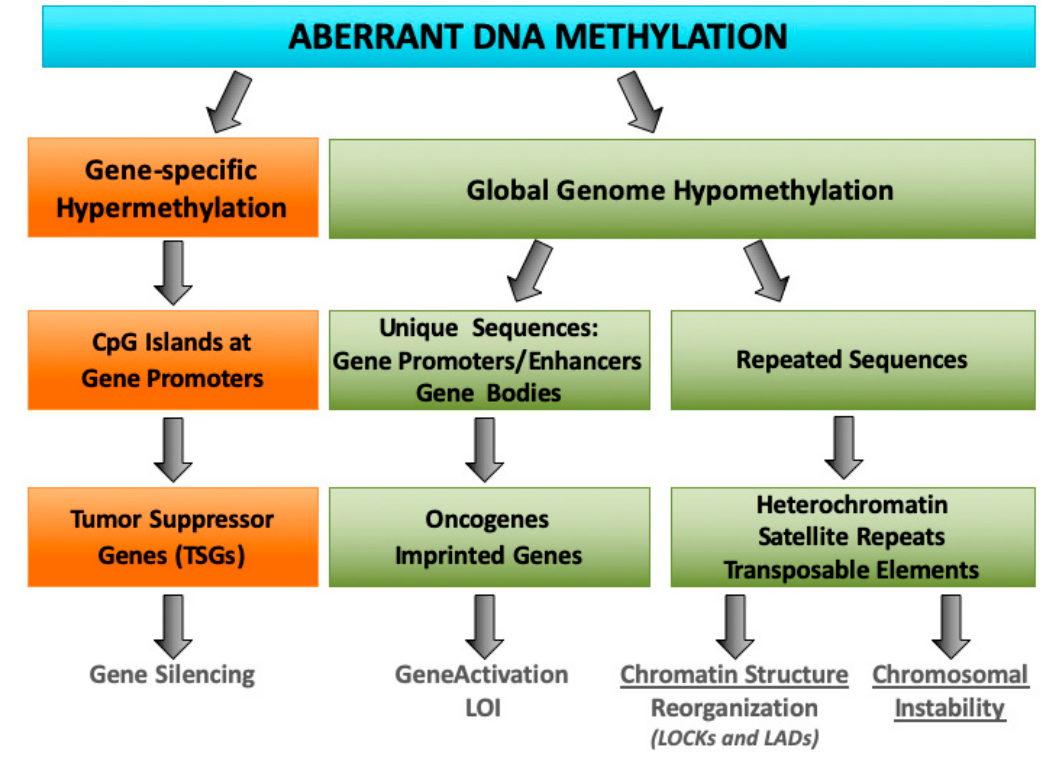
Figure 1. Scheme of aberrant DNA methylation in cancer cells. Left (orange): Locus-specific hypermethylation of CpG island in promoter sequences leads to transcriptional inactivation of tumor suppressor genes in cancer cells. Right (green): Global cancer-associated hypomethylation a ff ects both unique and repeated sequences. Hypomethylation of unique sequences participates to the activation of oncogenes, mediated by transcriptional enhancers and LOI of imprinted genes involved in cell growth control and tumorigenesis. Hypomethylation of tandem repeats (centromeric and juxta-centromeric satellite DNA), interspersed repeats (Alu and LINE-1), and transposable elements is mainly responsible for chromosomal instability and genomic rearrangements. Loss of DNA methylation within heterochromatic regions corresponding to the LOCKs and LADs (exhibiting high DNA methylation levels and association with nuclear membrane in nonneoplastic cells), results in structural reorganization of large heterochromatin blocks and disorganization of the nuclear